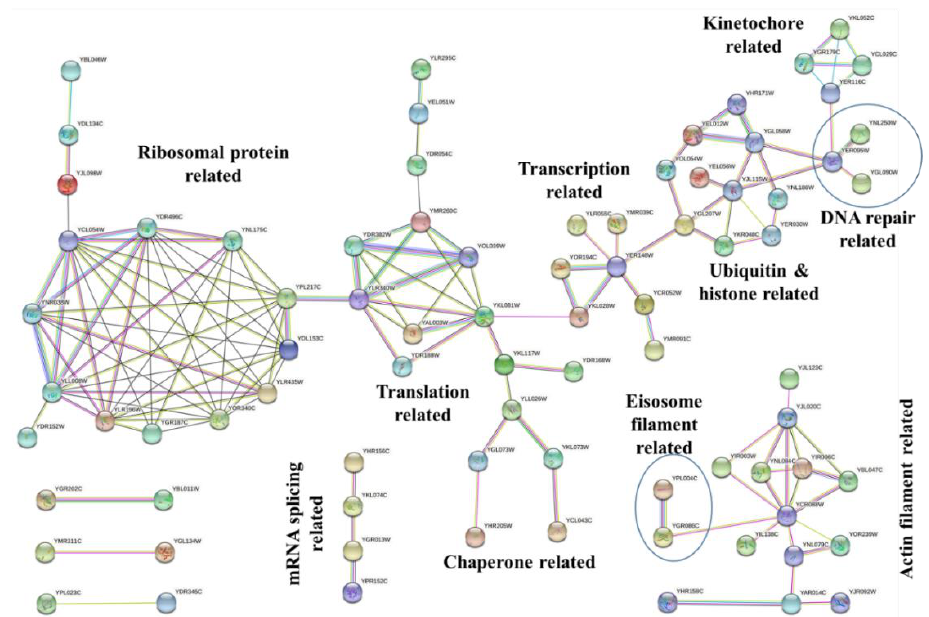
Figure 4. STRING analysis for protein – protein interactions among protein targets of Sub5. Protein targets of Sub5 showed few interaction hubs in STRING analysis. These hubs have functions in ribosome, translation, transcription, chaperone, actin, histone, DNA repair, and kinetochore. This figure was generated by using the STRING database, with high confidence of 0.7 as a cutoff for minimum required interaction score.